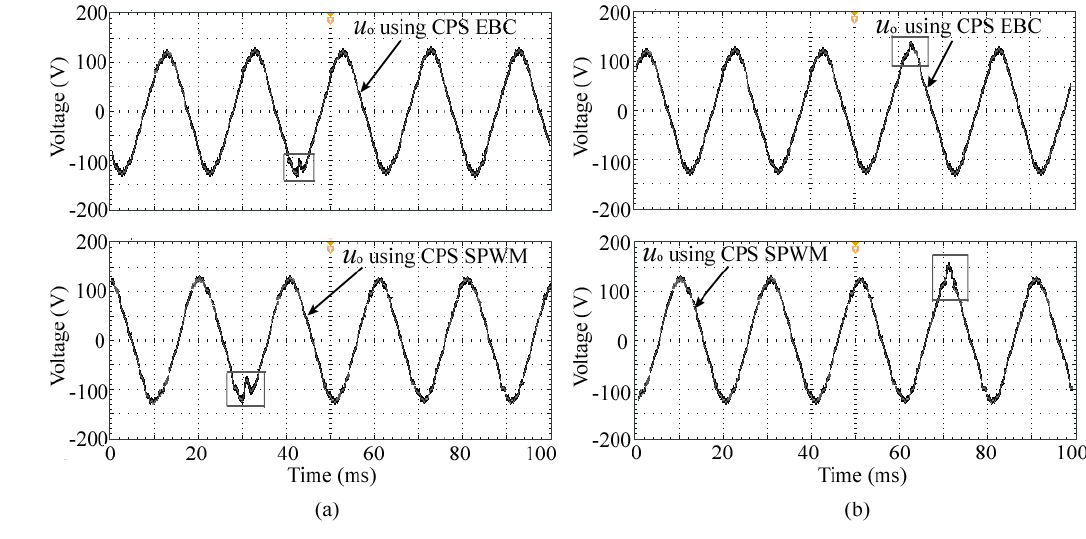
Figure 17. The experiment results of the five-level prototype under cases of load steps. ( a ) load steps as 50 Ω → 25 Ω ; and ( b ) load steps as 25 Ω → 50 Ω